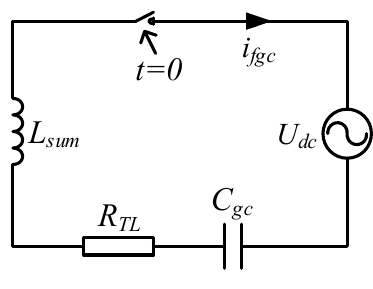
Figure 7. i fgc equivalent circuit.